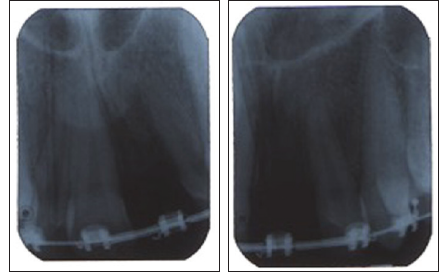
Figure 7. Pre-debond LCPA